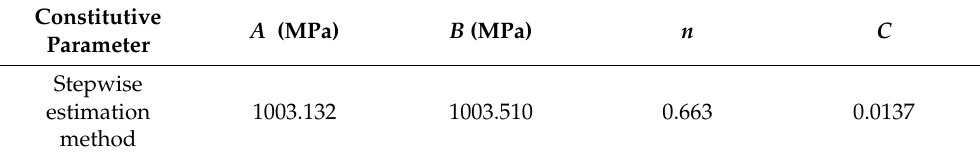
Table 2. Johnson–Cook constitutive model parameters of the TC4 titanium